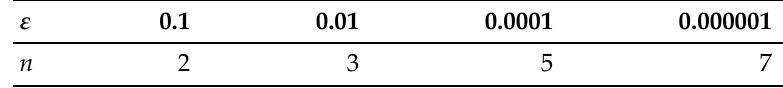
Table 3. Number of the necessary iterations needed if started with x = 5 in X to get an ε a posteriori error